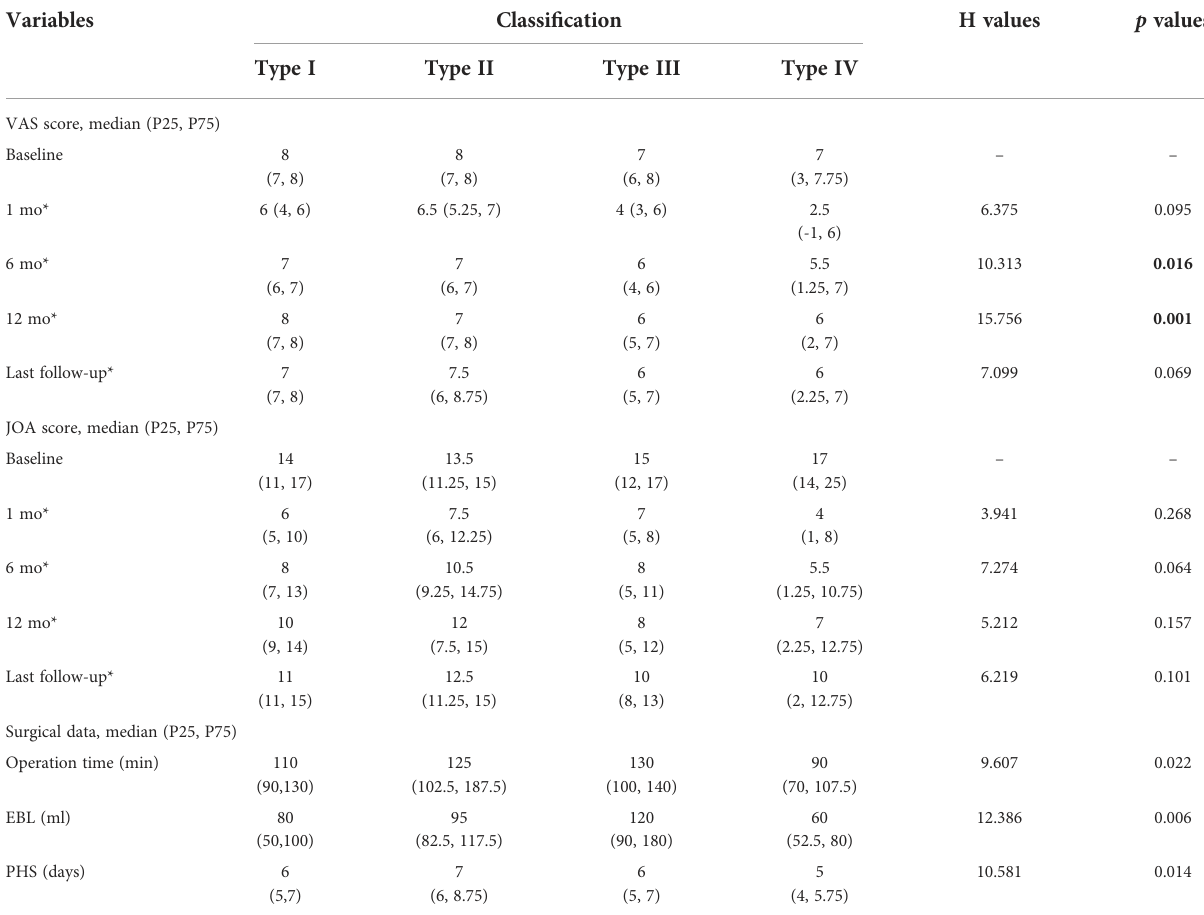
TABLE 2 Results of clinical outcomes and surgical data among patients with different Eden types.